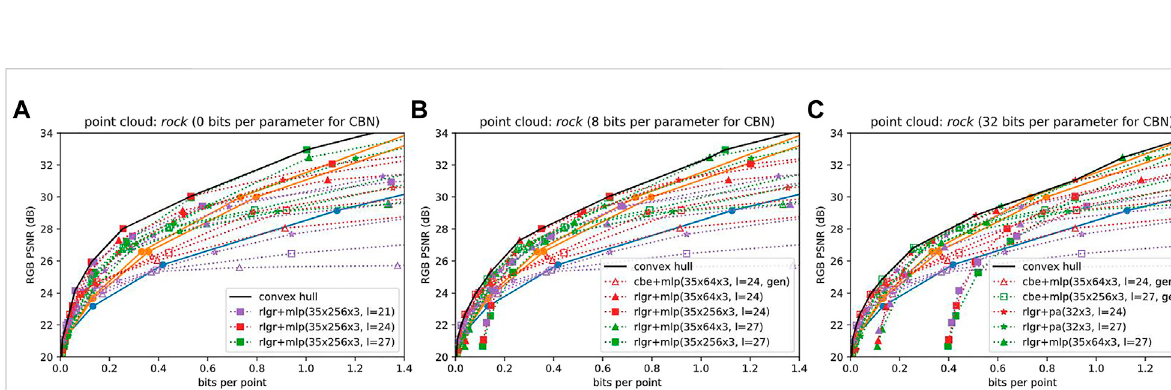
arithmetic coding with various coding modes, while RAHT + RLGR uses RLGR. We use RAHT + RLGR as our baseline because our experiments use RLGR as our entropy coder; the speci fi c entropy coder used in TMC13 is dif fi cult to extract from the standard. The latest version, TMC13 v14.0 (October